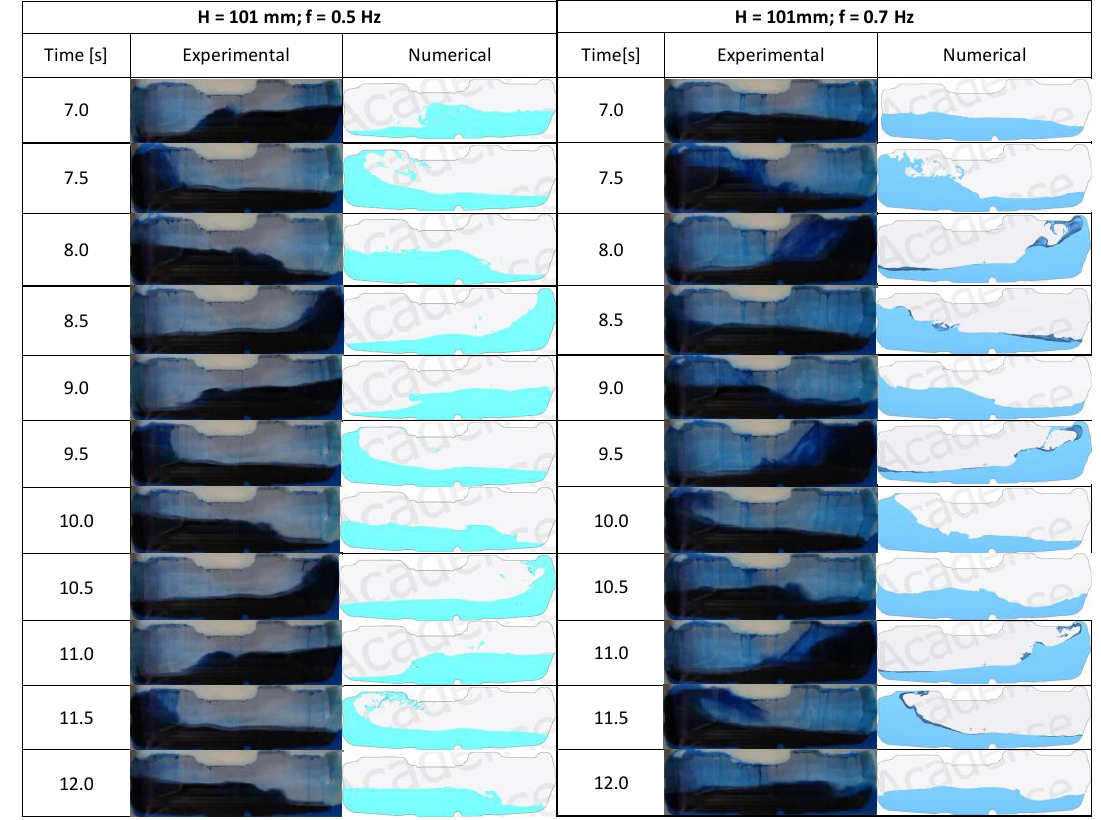
Figure 13. Comparison between numerical and experimental data in the time interval [7 ÷ 12] s for H = 101 mm and frequency values of 0.5 Hz and 0.7 Hz.